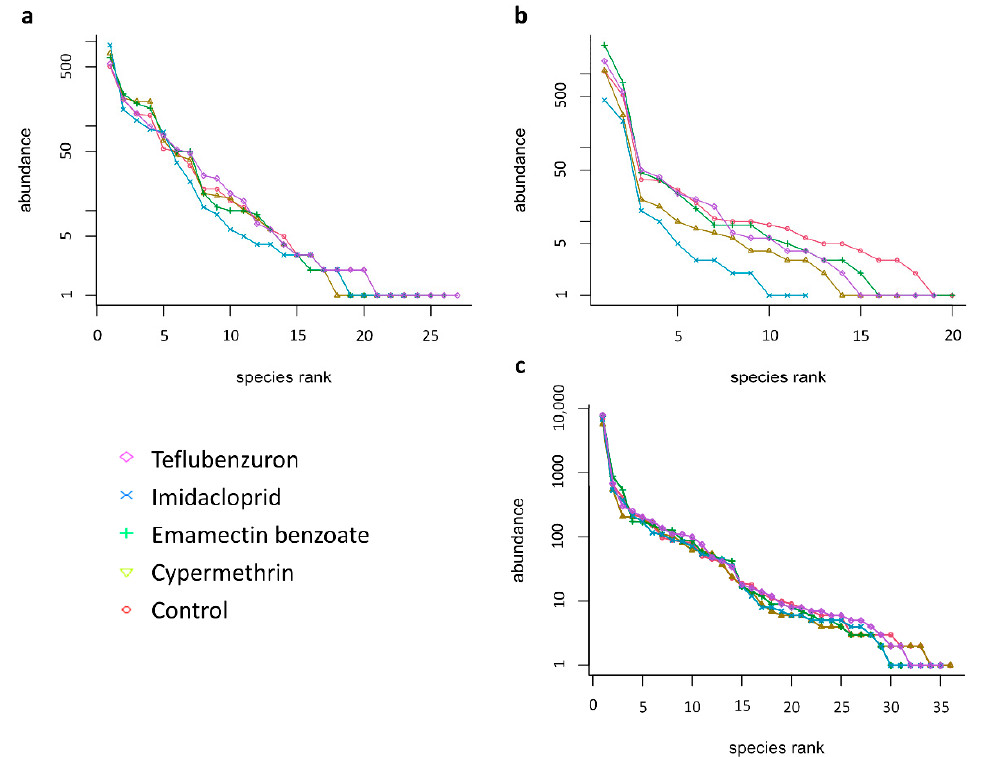
Figure 2. Rank abundance curves for the morphospecies found with the different sampling methodologies, per treatment (log series distribution): ( a ). pitfall trapping; ( b ). plant sampling; ( c ). pan